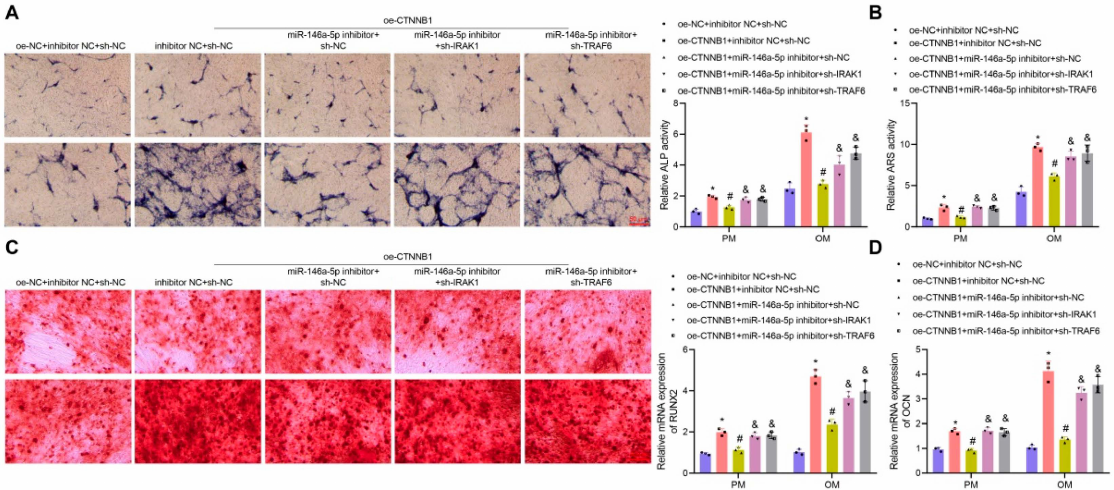
Figure 7. CTNNB1 induces the osteogenic differentiation of BMSCs by regulating the miR-146a- 5p/IRAK1/TRAF6 axis. BMSCs were cultured with PM and OM and treated with oe-CTNNB1, miR-146a-5p inhibitor, sh-IRAK1, or sh-TRAF6. ( A ) ALP staining for BMSCs and the quantitative results. ( B ) Alizarin red staining for BMSCs and quantitative results. ( C ) RT-qPCR detection of RUNX2 expression in BMSCs. ( D ) OCN expression in BMSCs determined by RT-qPCR. * p < 0.05 vs. the oe-NC + inhibitor NC + sh-NC group. # p < 0.05 vs. the oe-CTNNB1 + inhibitor NC + sh-NC group. & p < 0.05 vs. the oe-CTNNB1 + miR-146a-5p inhibitor + sh-NC group. Cell experiments were independently repeated three